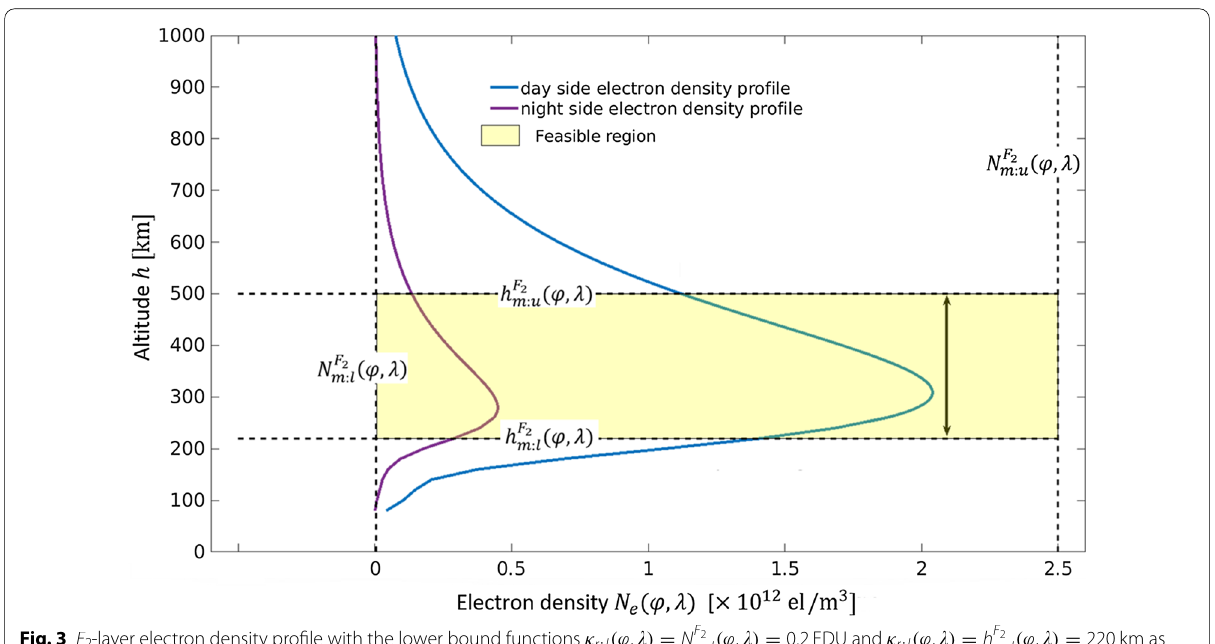
Fig. 3 F 2 -layer electron density profile with the lower bound functions κ r ; l (ϕ , (cid:31) ) = N F 2 m ; l (ϕ , (cid:31) ) = 0.2 EDU and κ r ; l (ϕ , (cid:31) ) = h F 2 m ; l (ϕ , (cid:31) ) = 220 km as well as the upper bound functions κ r ; u (ϕ , (cid:31) ) = N F 2 m ; u (ϕ , (cid:31) ) = 2.5 EDU and κ r ; u (ϕ , (cid:31) ) = h F 2 m ; u (ϕ , (cid:31) ) = 500 km of the 2 key parameters N F 2 m (ϕ , (cid:31) ) and h F 2 m (ϕ , (cid:31) ) at the spatial position (ϕ , (cid:31) ) ; the region within the bounds—highlighted in yellow colour—is denoted as the feasible region F R . The figure shows alongside also the day and night side electron density profiles, indicating that the bound functions are actually